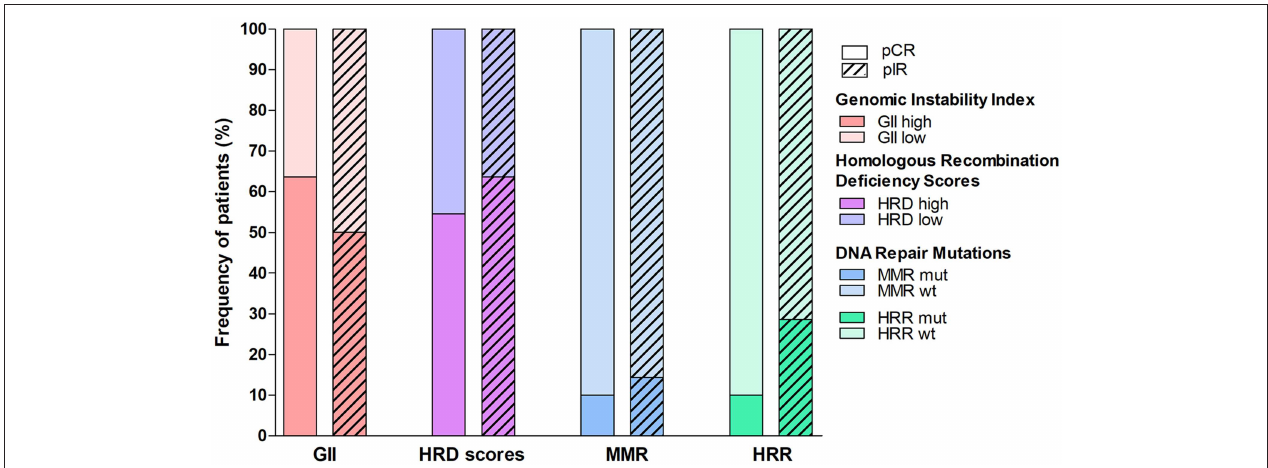
FIGURE 2 | Proportion of locally advanced rectal cases with pathological complete response (pCR) or incomplete response (pIR) to neoadjuvant therapy according to the genomic features evaluated in this study. Patients were divided into high or low levels of Genomic Instability Index (GII), elevated values of at least one of the three scores of Homologous Recombination Repair Deficiency (HRD scores), and mutation in genes related to DNA damage repair (mismatch repair-MMR or HR repair-HRR).